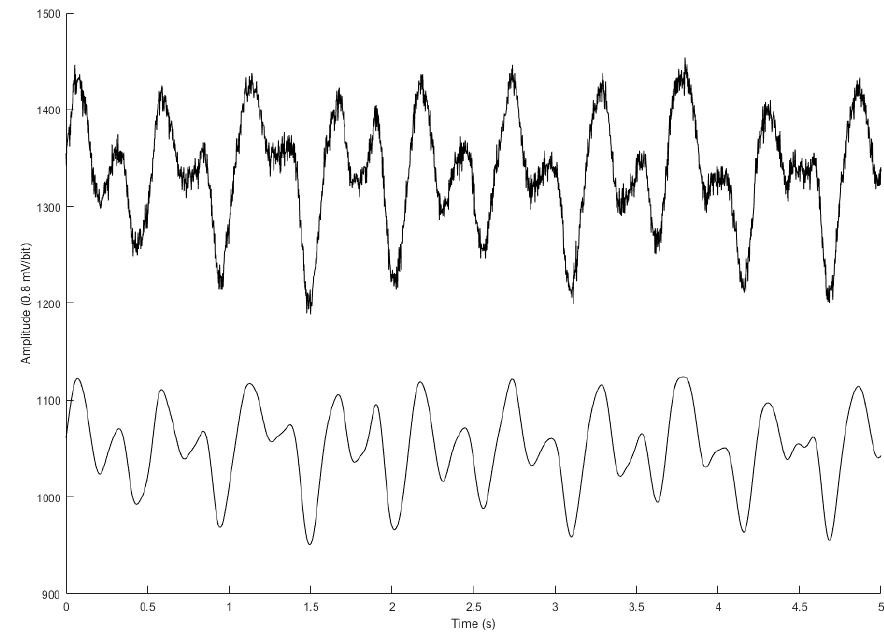
Figure 4. The raw (top) and filtered (bottom) IPG signals.